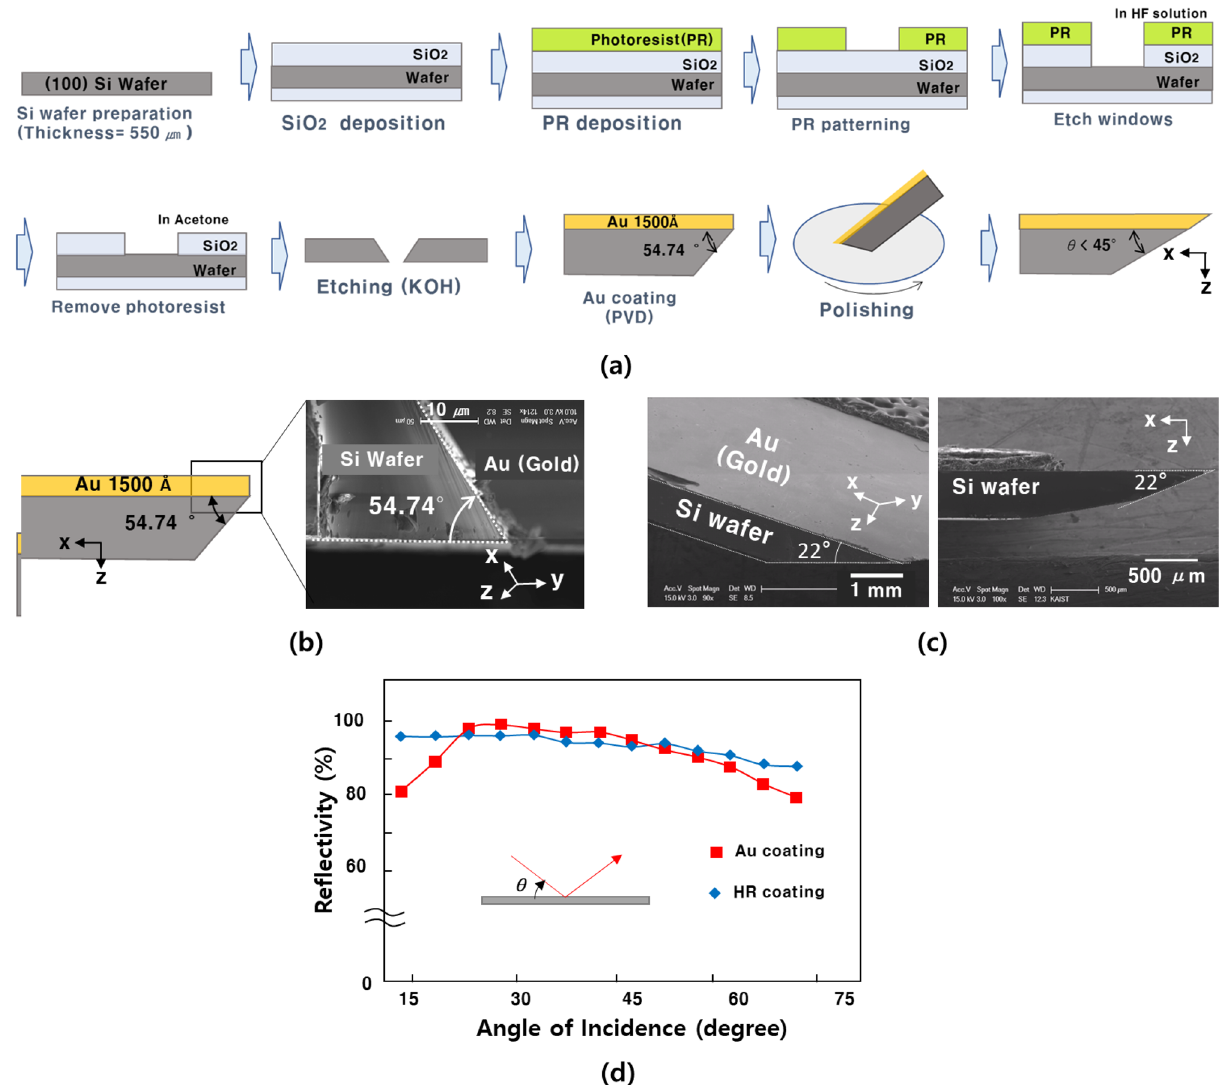
Figure 3. ( a ) Fabrication process of the reflecting mirror. The reflecting mirror is fabricated by a Si wafer with several steps. ( b ) SEM image of the gold-coated mirror. Before polishing the mirror tip, its angle is 54.74°. ( c ) SEM image of the gold-coated mirror. After polishing the mirror tip, its angle is 22°. This result satisfies the designed angle. ( d ) Reflectivities of the HR and gold-coated reflecting mirrors according to various mirror